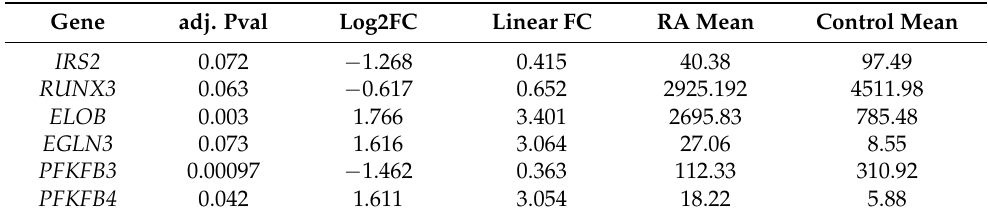
Table 18. Differential expression of regulators of glycolysis in untreated RA CD8 + Tem cells. Means are calculated from DESeq2 normalized